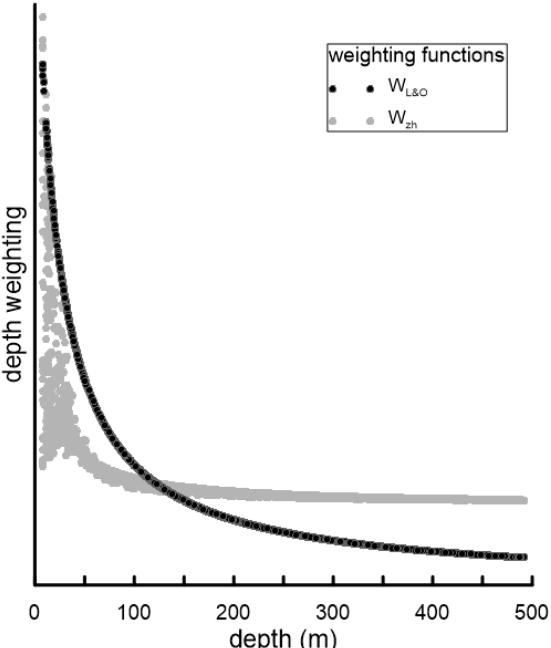
Figure 2. Depth weighting versus depth for two weighting functions on unstructured grids. Results in Figure 2 are calculated over an area of 500 m × 500 m × 500 m composed of tetrahedral grids. z 0 is chosen to be 20 in Equation (14). As volume of grids are different for tetrahedral meshes, the depth weighting Zh W is normalized by cell volumes. In Figure 2, similar tendencies can be seen from two weightings.